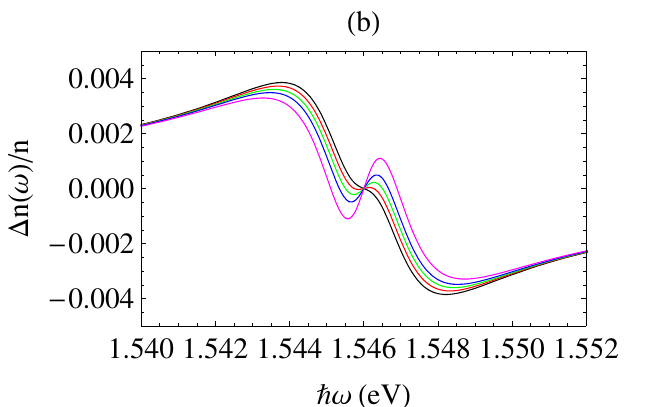
Figure 6. (Color online) The same as in Figure 3 but for the electric field polarized along the x axis.